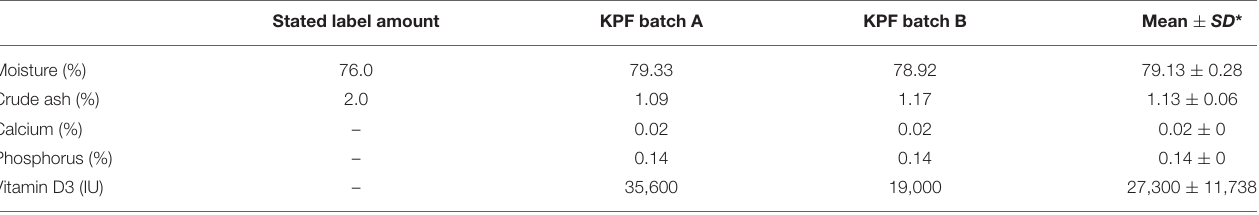
TABLE 2 | Declared vs. measured moisture, crude ash, minerals, and vitamin D3 content of kitten pet food (batch A and B). The data are expressed as %, or IU/100g, of OS.